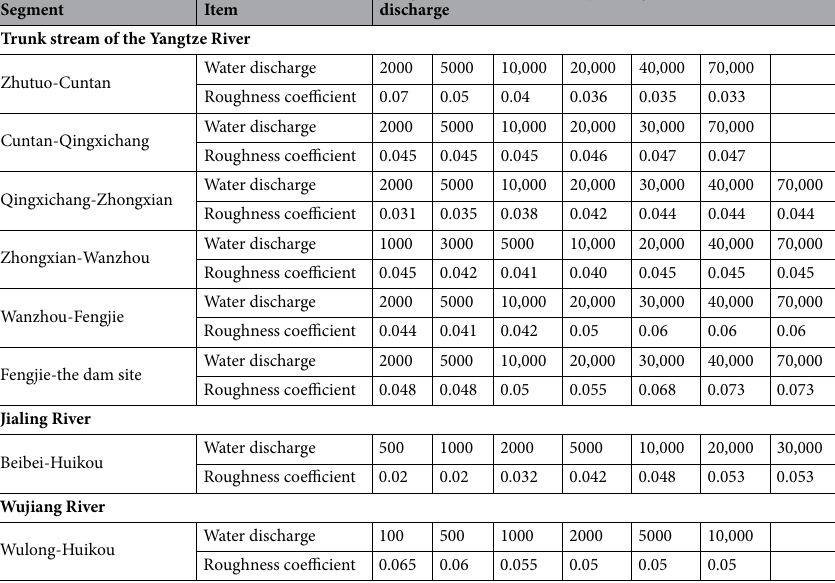
Table 2. Statistical table of the piecewise comprehensive roughness coefficients of the TGR.